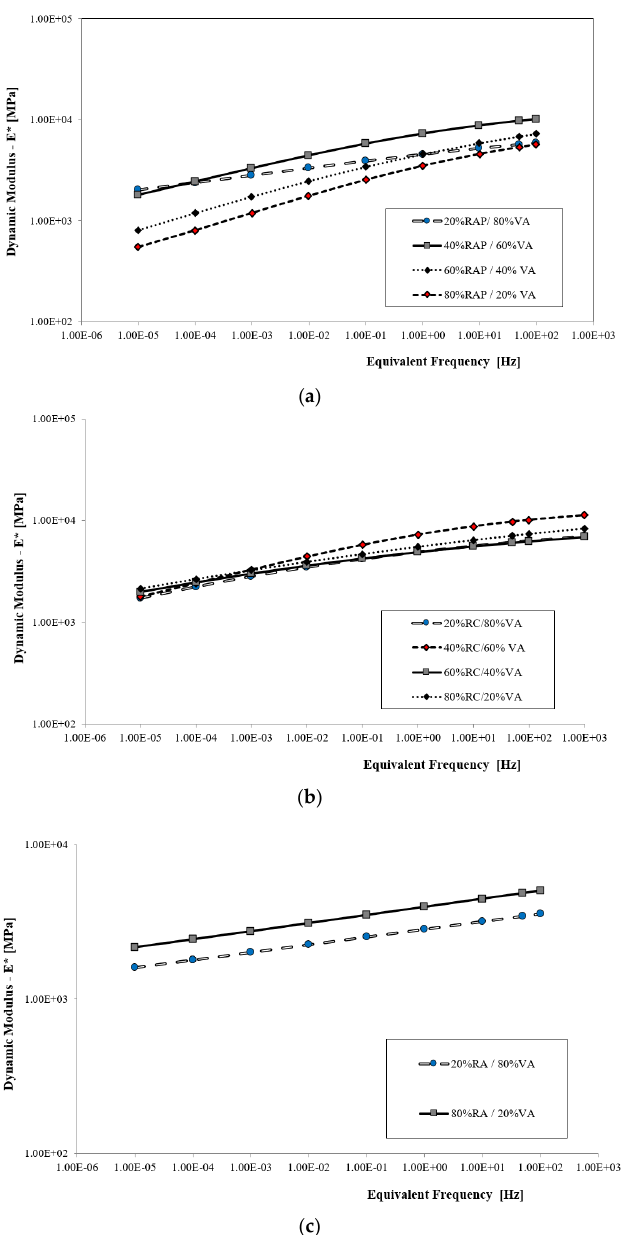
Figure 9. Master curves of the dynamic modulus E * at a temperature of 13 °C for FB-RCM mixtures with ( a ) reclaimed asphalt pavement (RAP), ( b ) recycled cement concrete (RC) and ( c ) recycled aggregate (RA).